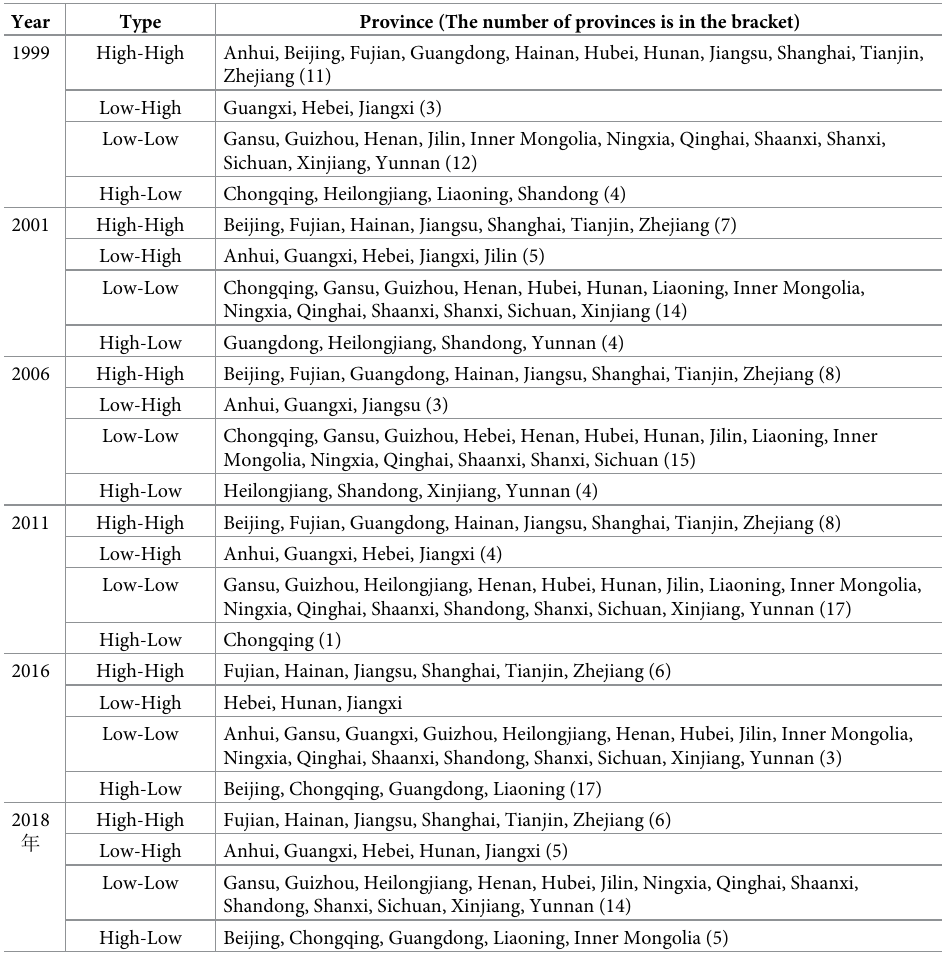
Table 7. Clustering types of high-quality industrial development in various provinces in 1999, 2001, 2006, 2011, 2016 and 2018. Province (The number of provinces is in the bracket)